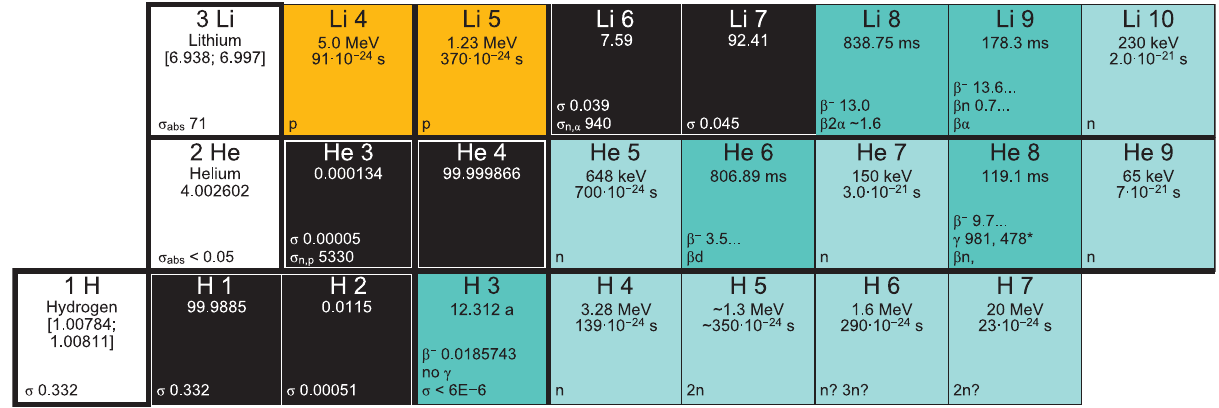
Fig. 7. Excerpt from the 10th edition of the Karlsruhe Nuclide Chart. The three horizontal lines show isotopes of elements H, He and Li. The white boxes represent the chemical element and contain the standard atomic weights and thermal neutron cross sections for the